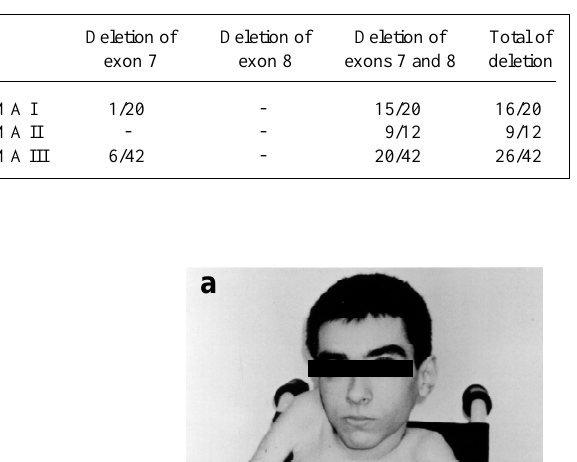
Table I - Analysis of SMN gene in patients.